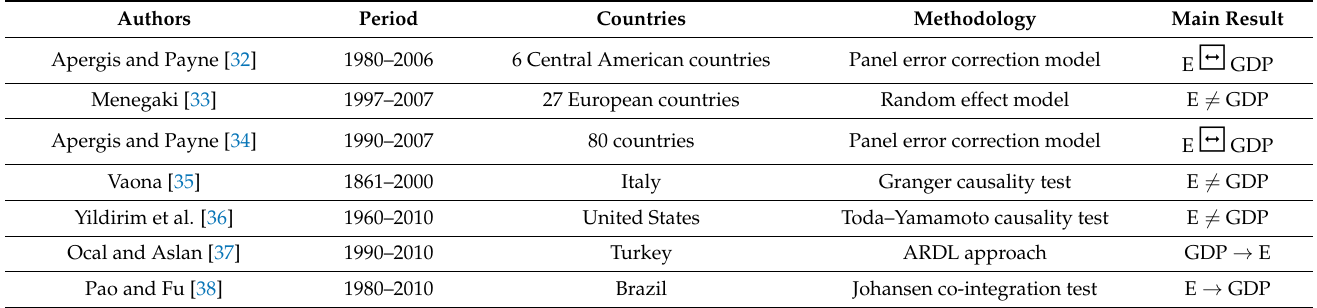
Table 1. Key findings of the relationship between renewable energy and economic growth.